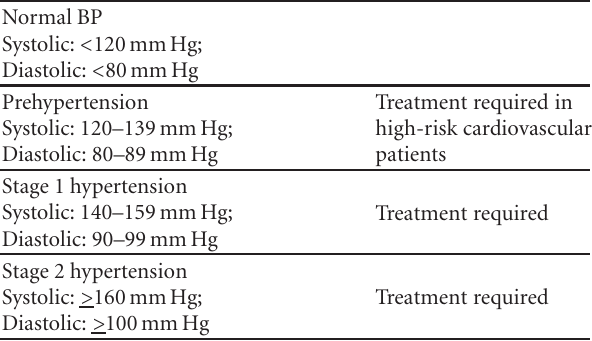
Table 3: Joint National Commission7 (JNC 7) Blood Pressure (BP)